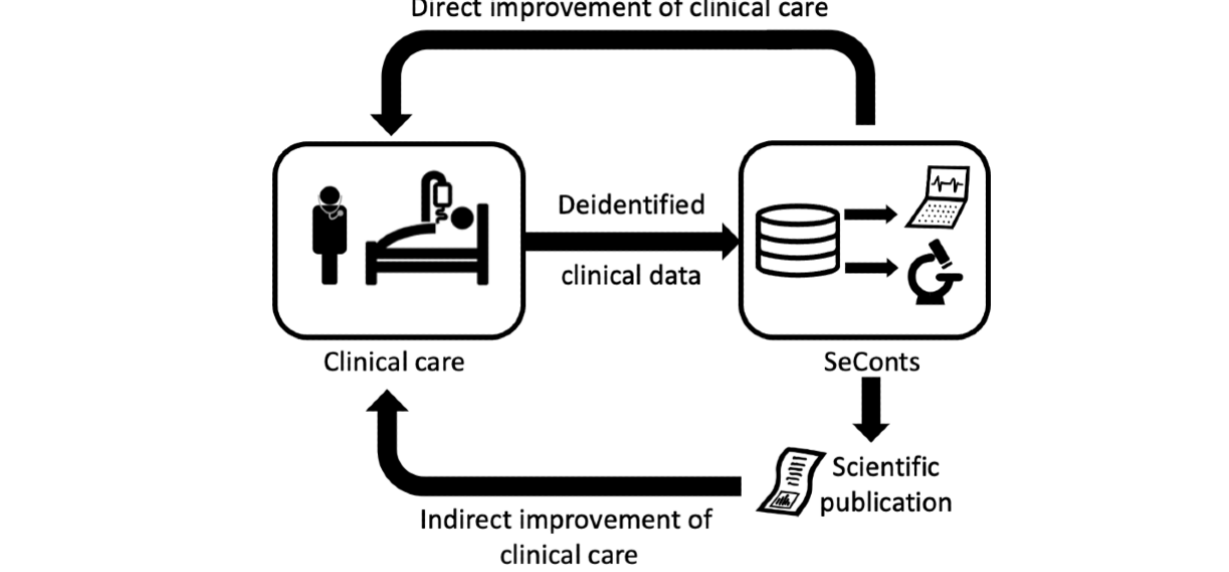
Figure 1. Flowchart of the secondary use of clinical data in data-gathering, non-interventional research or learning activities.